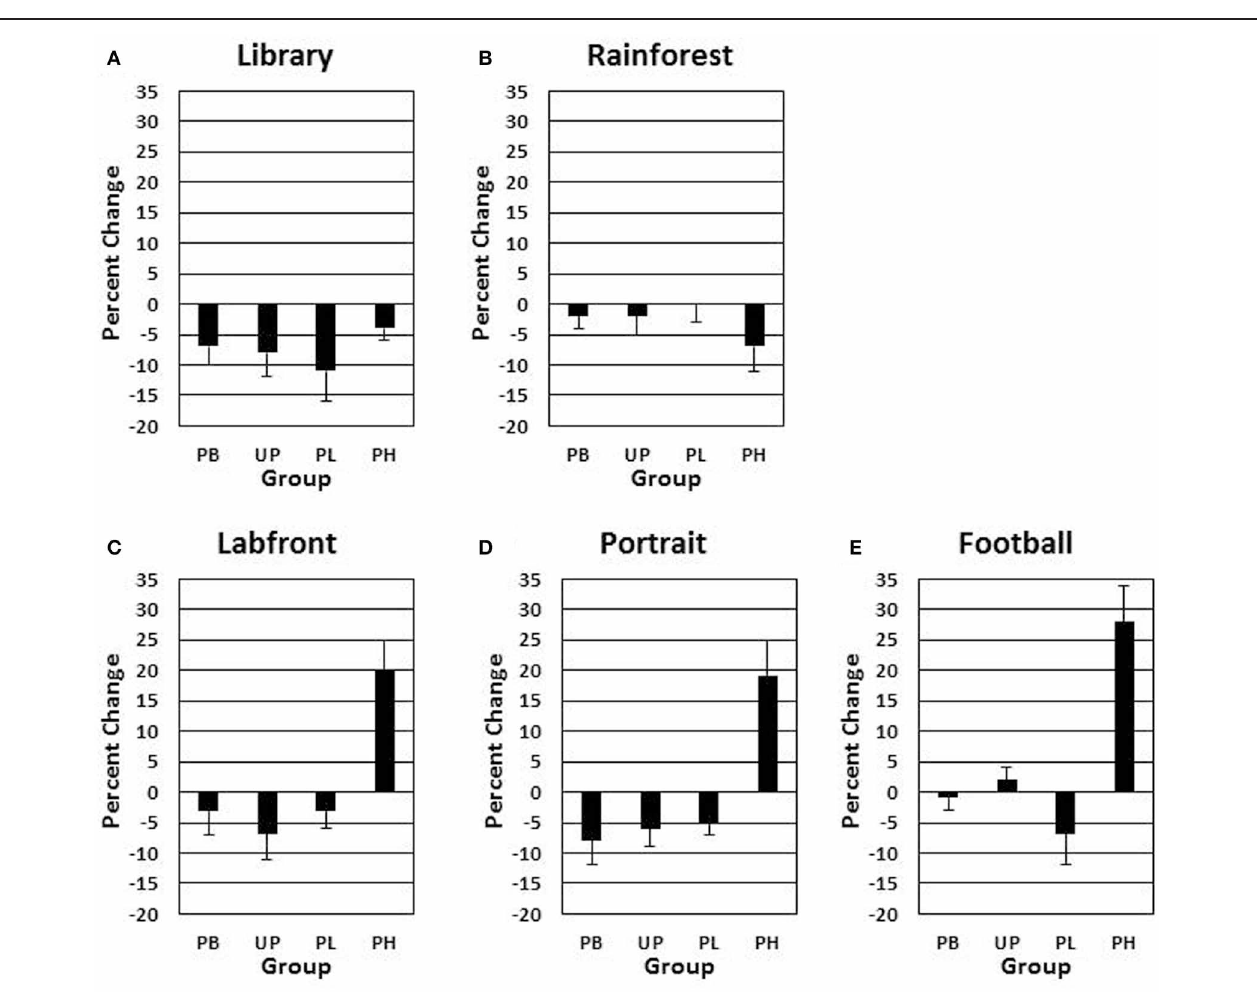
FIGURE 3 | Conditioned contextual facilitation of motor velocity during the Association phase for four experimental groups. Shown is the degree of contextual facilitation (% change from Association day 1 to Test day 4) of motor velocity (finger tapping) induced by 5 video clips